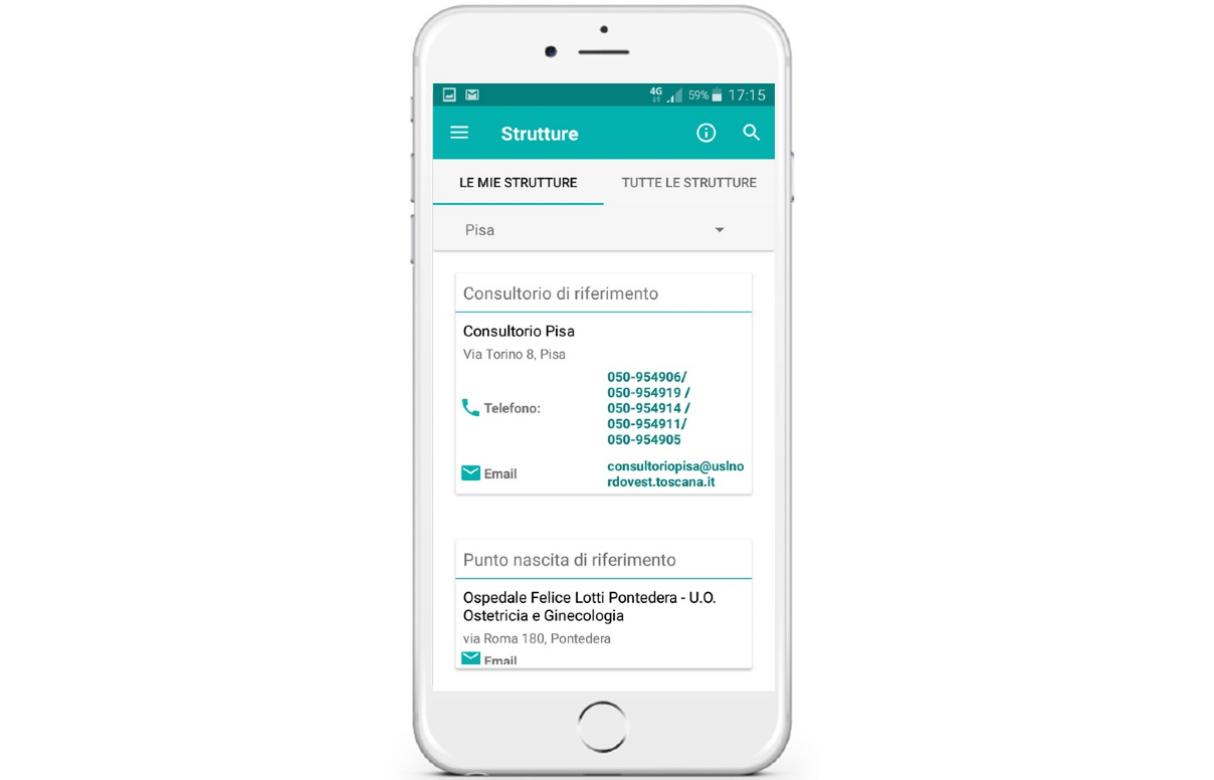
Figure 5. hAPPYMamma facilities repository: information on family care centers and delivery hospitals, with logistic details, services provided, and georeferencing system